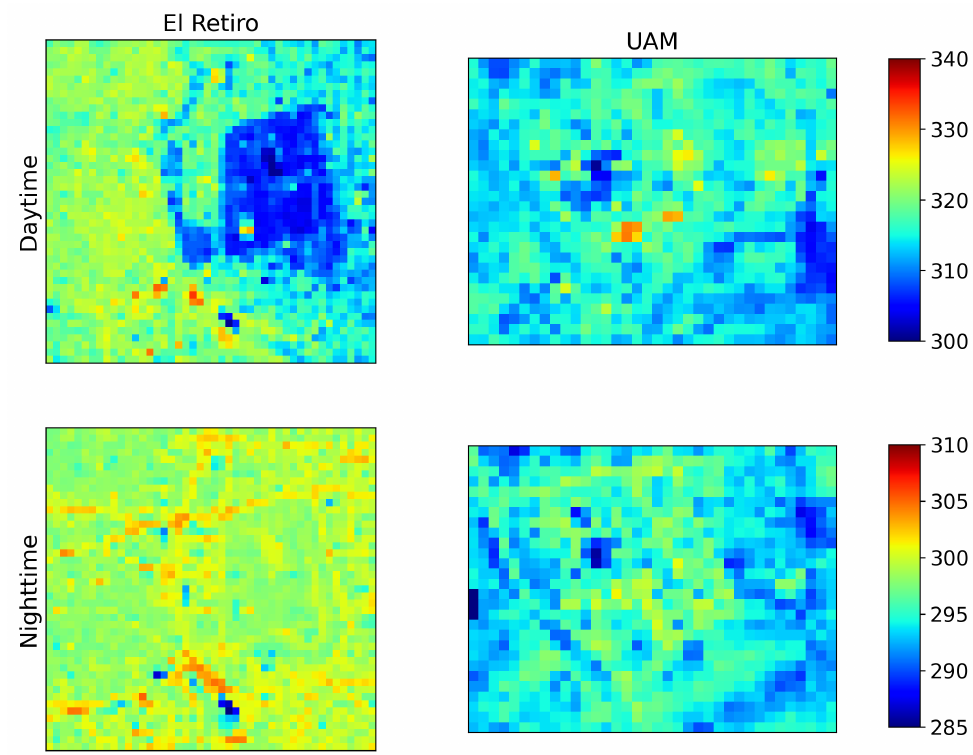
Figure 13. The 60-m aggregated LST from the 1MMD-4-band TES over the Retiro park ( left ) and the UAM ( right ) during the daytime ( top ) and nighttime ( bottom ).